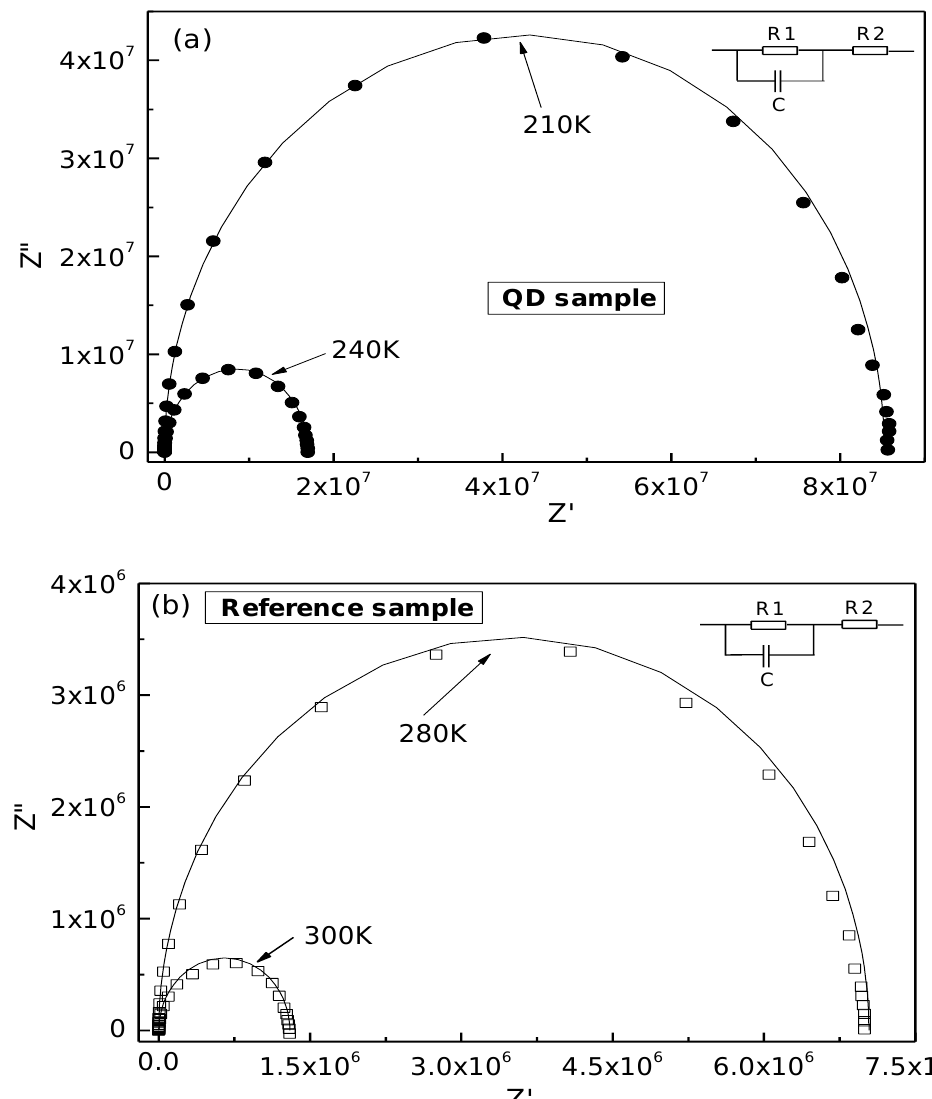
Figure 7. Complex impedance plane plots for the quantum dot ( a ) and reference sample ( b ). Empty squares and full dots—experimental data, solid lines—fitting with the electric circuit shown in the insets.